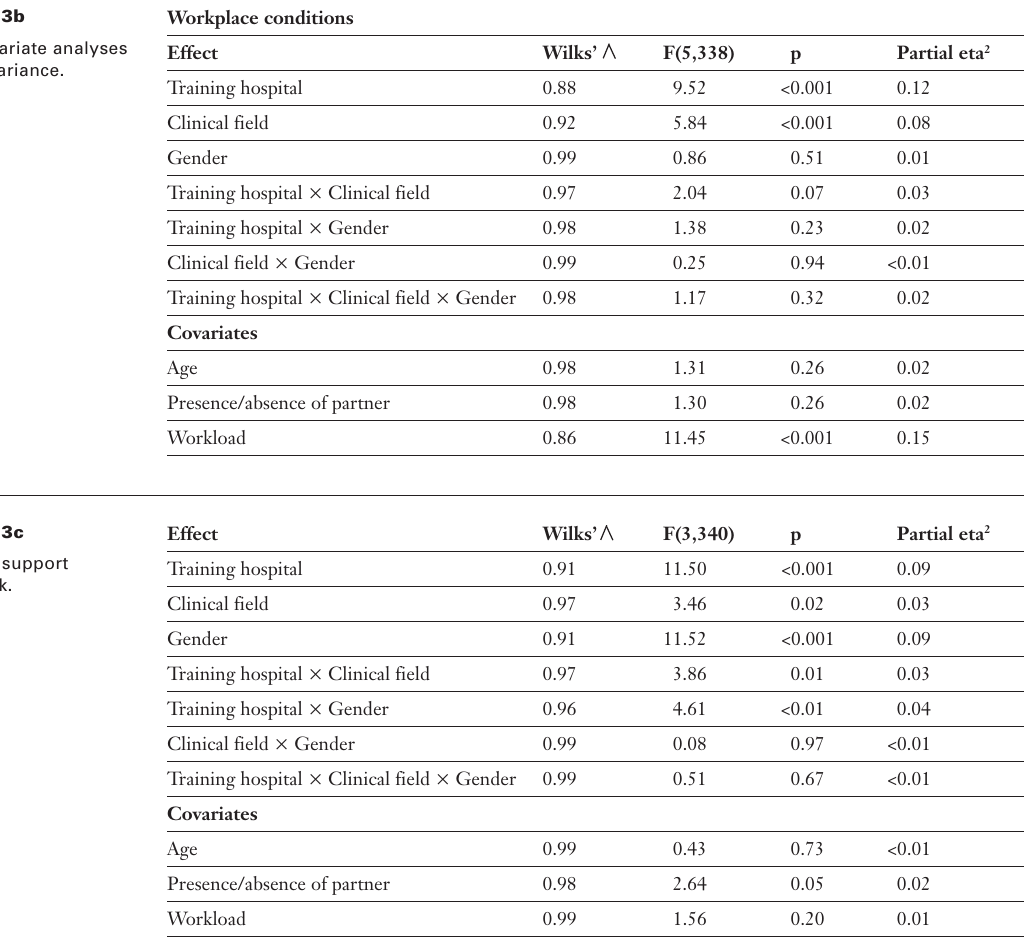
Means and Delta crit (standard error of means (SE) (cid:1) 1.96) of workplace experi- ence scales (Work- place Conditions short questionnaire, Social Support at Work questionnaire, Effort-reward imbal- ance, Over-commit- ment) related to type of training hospital (“A”- versus “B”/“C”/“D”-hospi- tals), clinical field (surgical versus inter- nal field) and gender, and results of multi- variate analyses of covariance (covari- ates: age, presence or absence of part- ner, workload), n = 353.